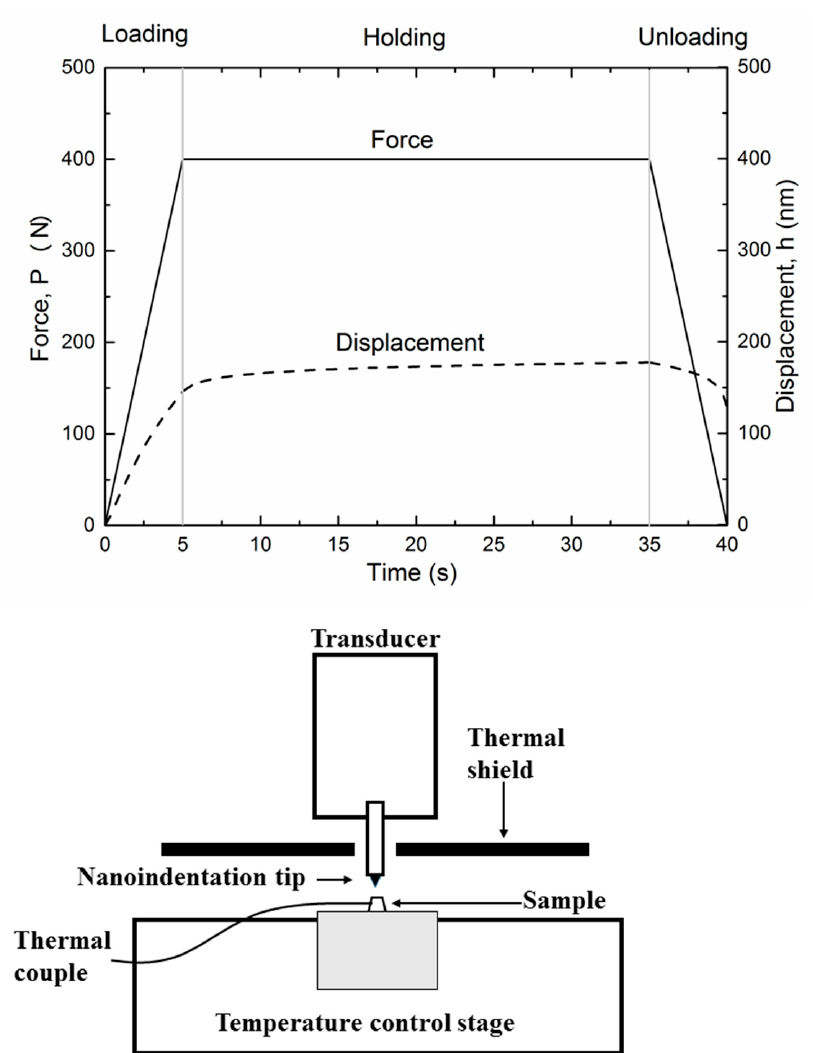
Figure 1. The load force–displacement curve of nanoindentation and the schematic diagram of the nanoindentation system [28].